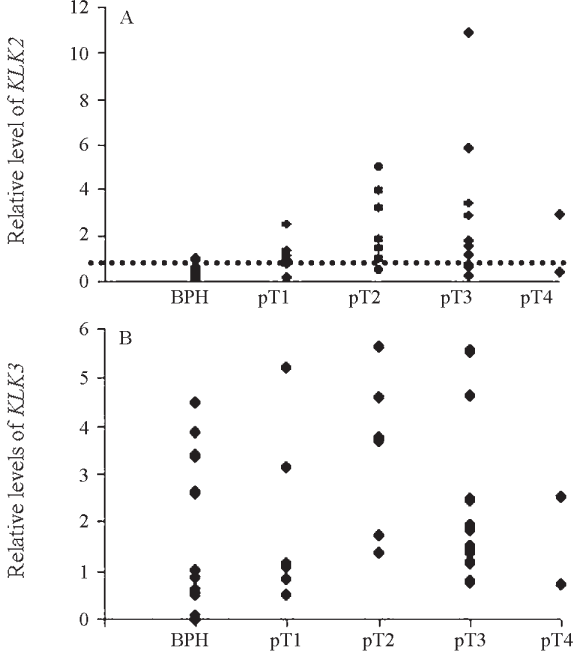
Figure 2 - Relative expression of KLK2 (A) and KLK3 (B) genes in pa- tientsaccordingtotheirTNM(Tumor,lymphNodeandMetastasis)tumor staging (pT1, pT2, pT3 and pT4) and benign prostatic hyperplasia (BPH) classification. The dashed line represents the 0.6 KLK2 cutoff expression limit for discriminating prostate cancer patients from BPH